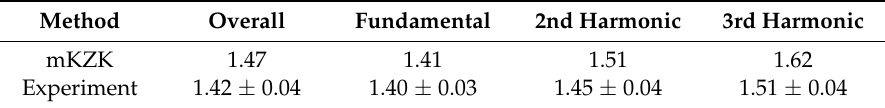
Table 1. Focus shift induced by acoustic-dispersive phantom sample (in